Question: In one sentence, what is this figure communicating?
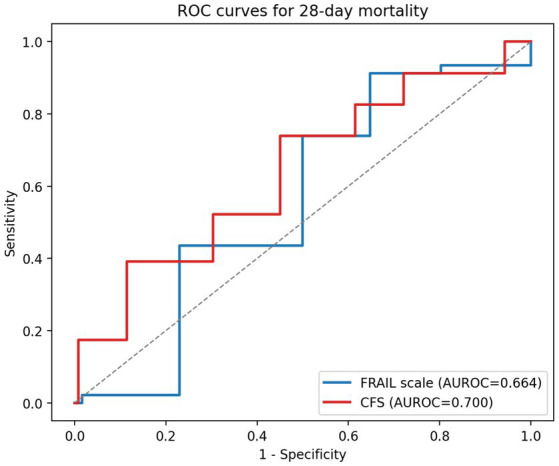
Answer: Receiver operating characteristic curves for FRAIL and CFS total scores predicting 28-day mortality.